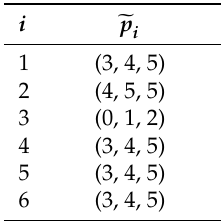
Table 6. Evaluation